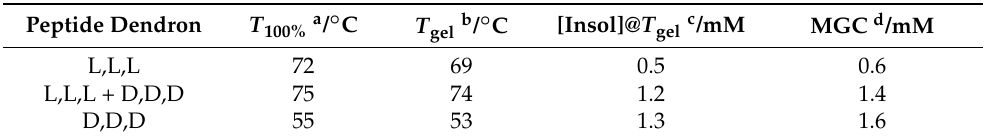
Table 4. Comparison of data calculated from VT NMR experiments with peptides and C8R and macroscopically observed data for gels with 10 mM amine and 10 mM total peptide dendron concentration in d 8 -toluene.